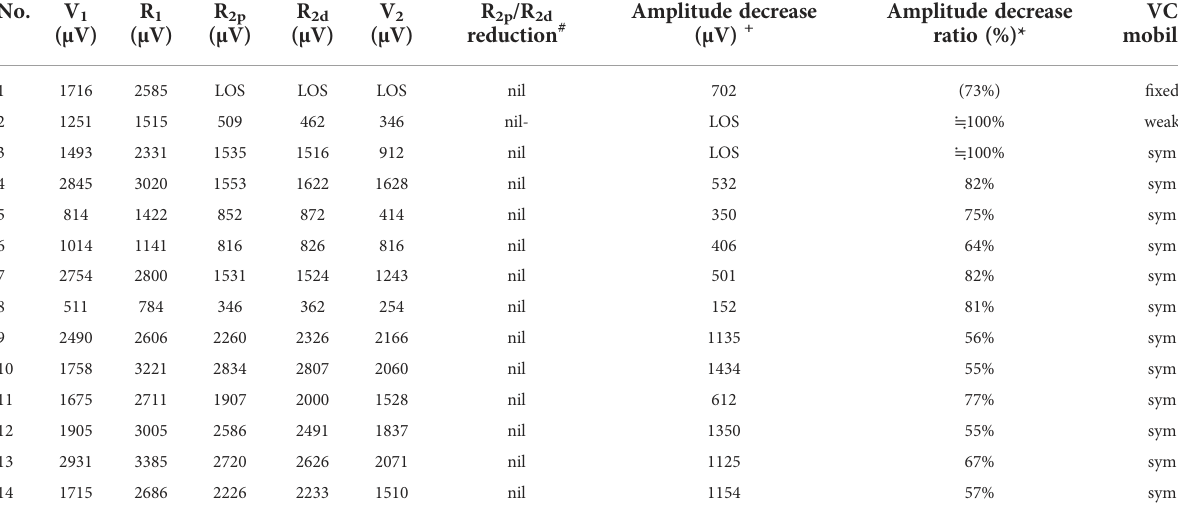
TABLE 3 Type C EMG recovery pattern (incomplete EMG recovery without injury point detected on RLN).